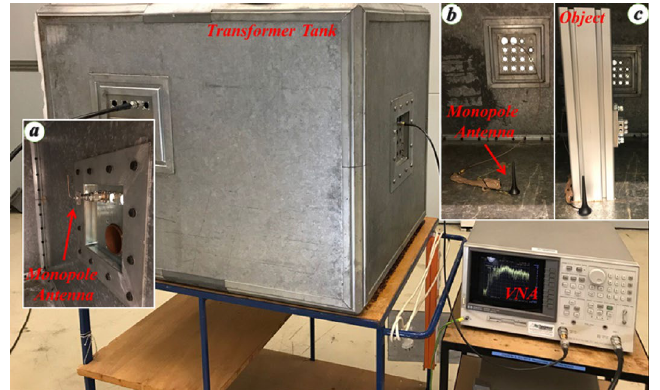
Figure 7. Test setup including the model for the transformer tank and the VNA. ( a ) The monopole antenna used as a sensor, ( b ) the monopole antenna used to emulate the PD source, and ( c ) metallic object representing the transformer winding.